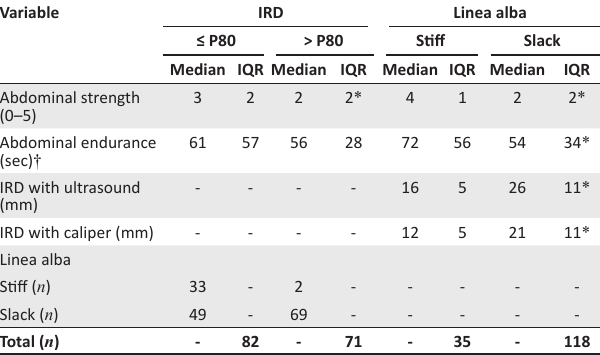
FIGURE 2: Receiver operating characteristics curve for determination of normal interrecti distance according to the linea alba stiffness ( n = 153). TABLE 2: Relationships between IRD, linea alba stiffness, abdominal muscle strength and endurance in the sample of postpartum women ( n = 153). Variable